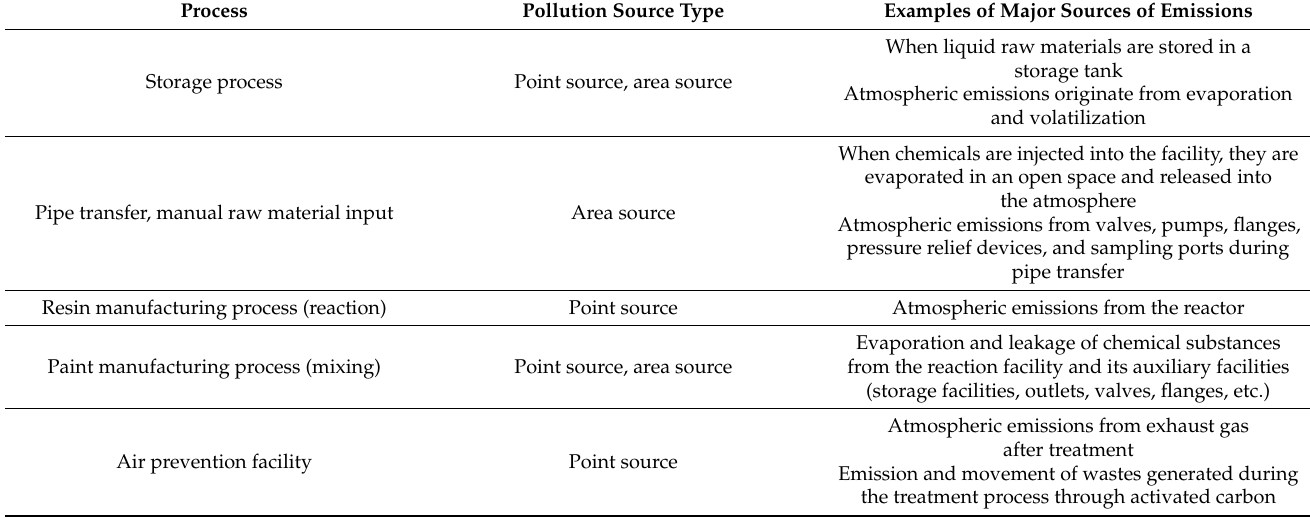
Table 1. Characteristics of VOC pollutants that can be emitted by the process of the research targeting the paint manufacturing